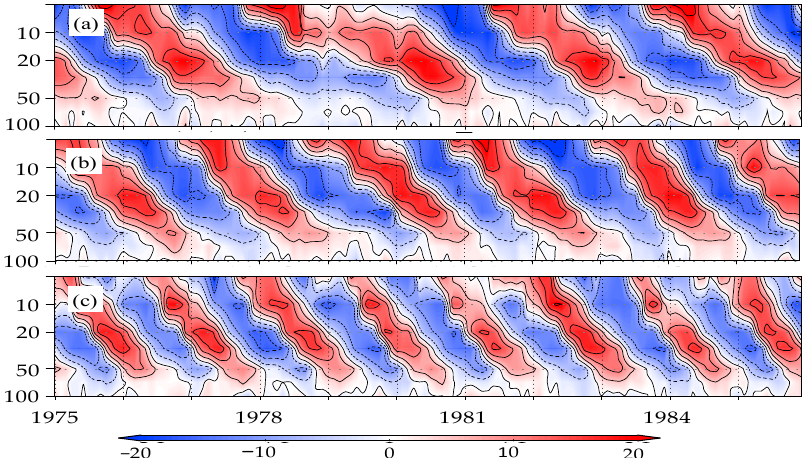
Figure 2. Time–height cross-sections of zonal–mean zonal wind anomalies (ms − 1 ) averaged between 10 ◦ S and 10 ◦ N in the tropical stratosphere (100–5 hPa) for the ( a ) Q (+10%), ( b ) M ( − 10%), and ( c ) L ( − 40%) runs from 1975 to 1985. Contours interval is 5 ms − 1 .